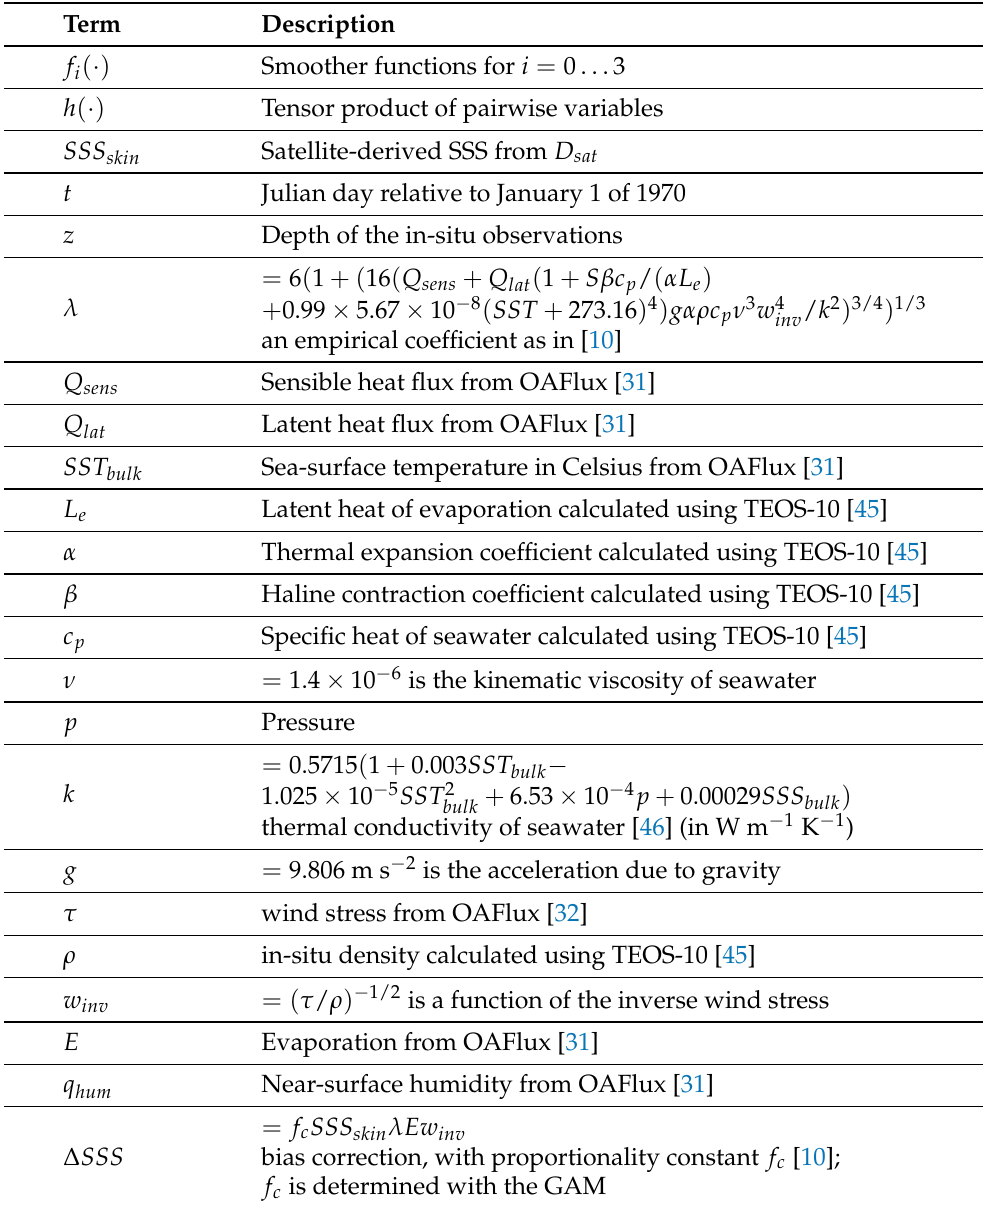
Table 1. Descriptions of each term in Equation